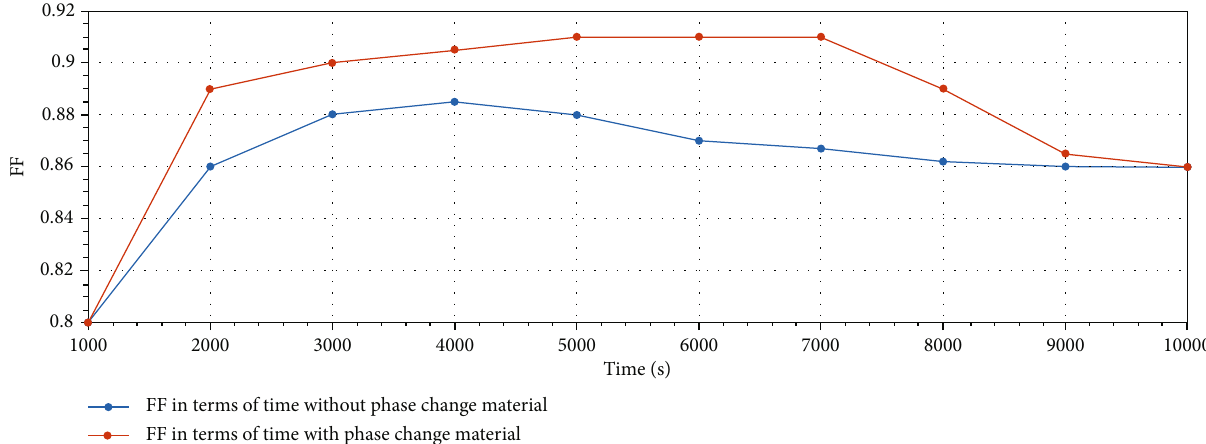
Figure 6: Filling factor in terms of time, assuming a radiation intensity of 1000 watts per square meter in the state with and without the phase change material.